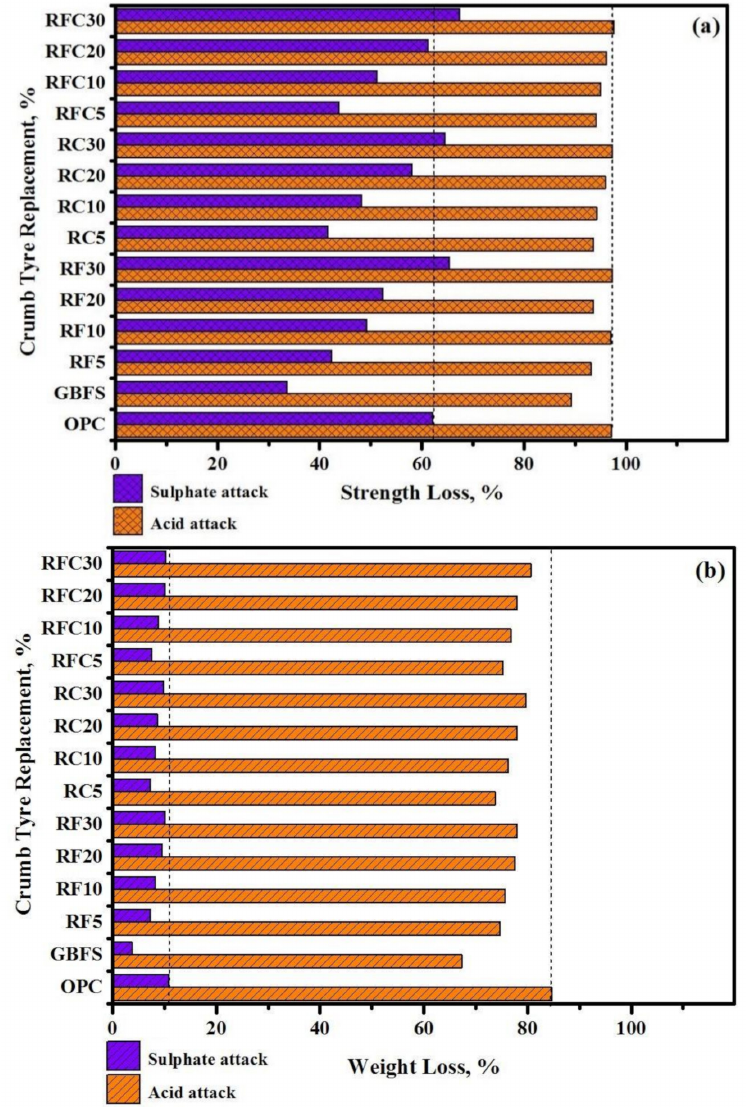
Figure 2. Effect of MgSO 4 and H 2 SO 4 on ( a ) compressive strength (CS) and ( b ) weight loss of modified rubberized